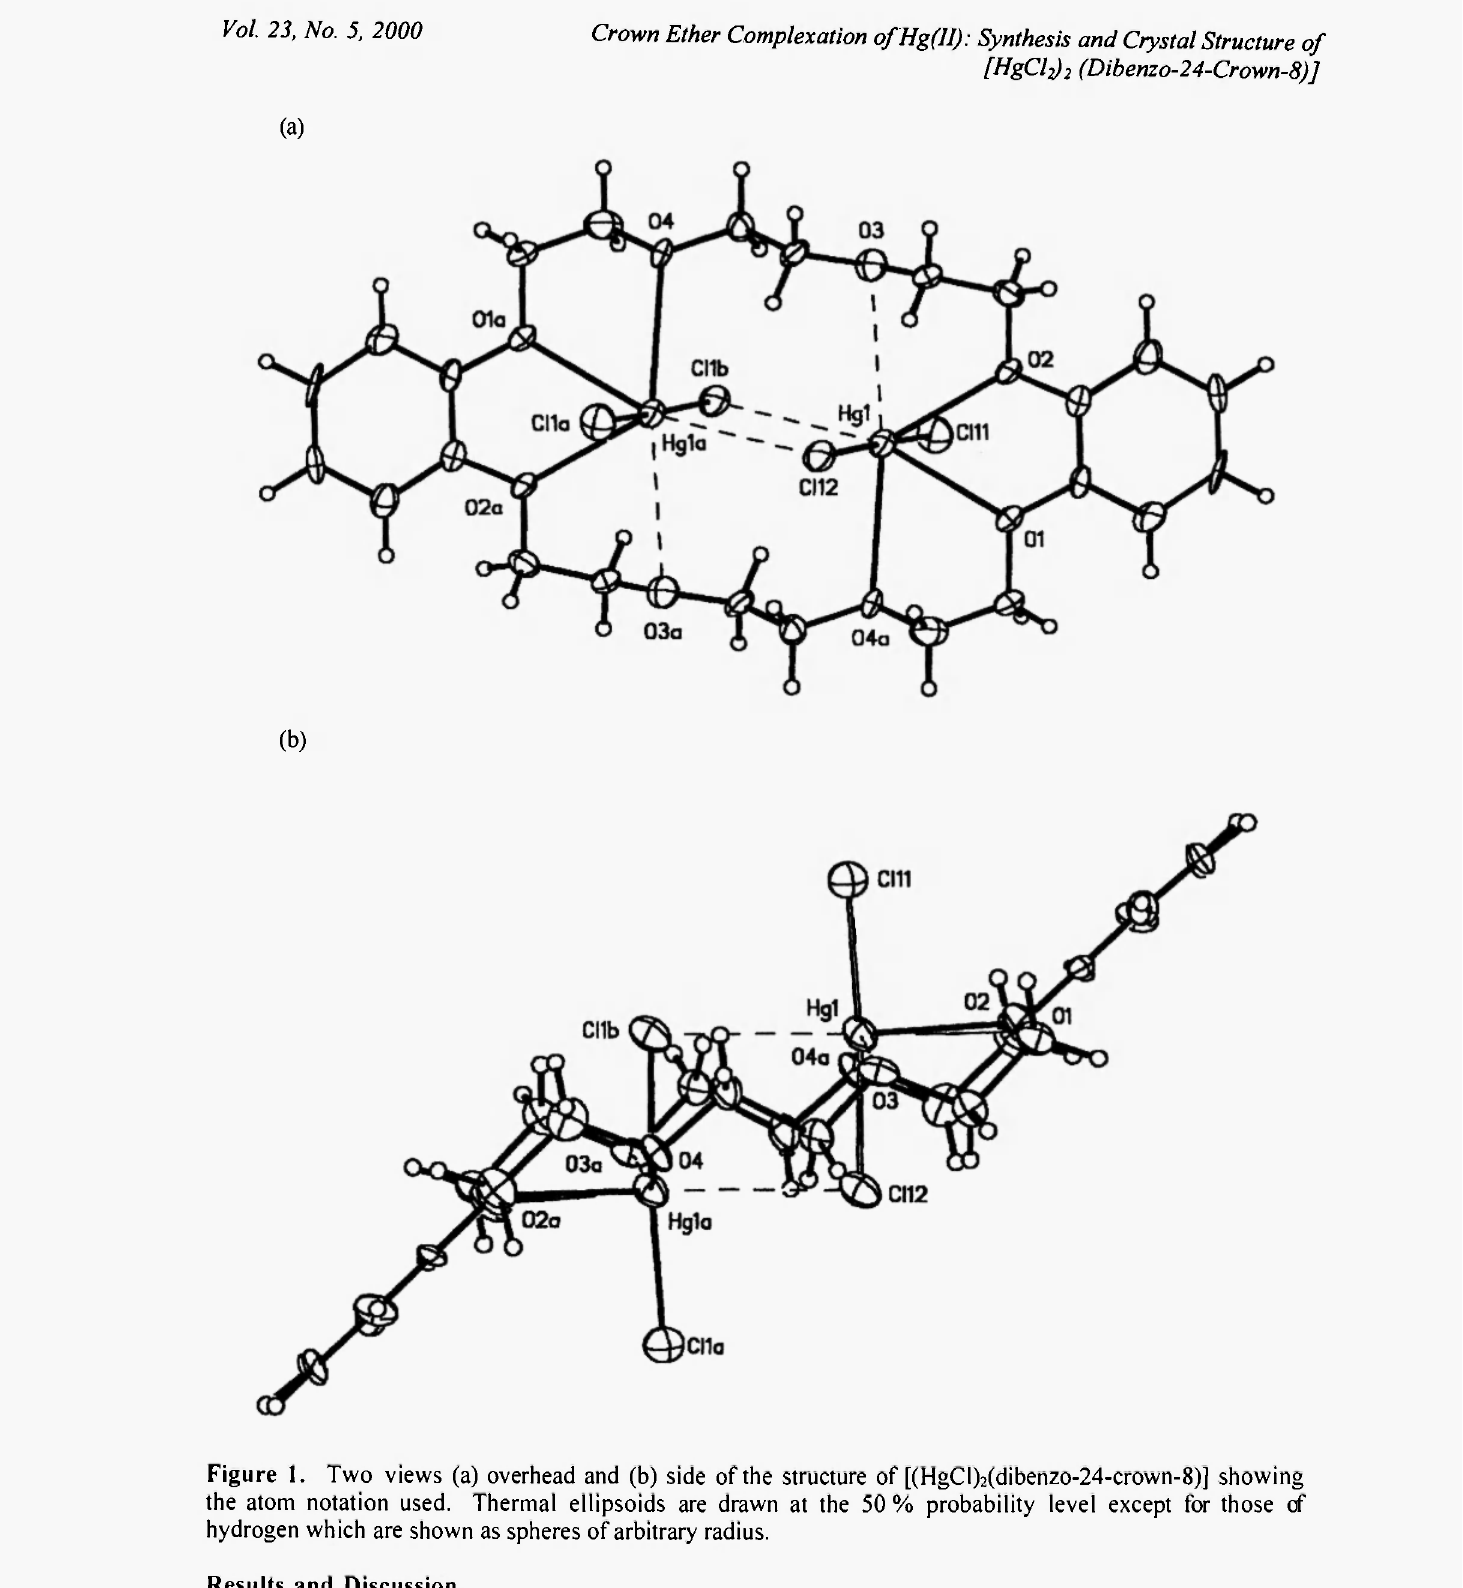
Figure I. Two views (a) overhead and (b) side of the structure of [(HgCI) 2 (dibenzo-24-crown-8)] showing the atom notation